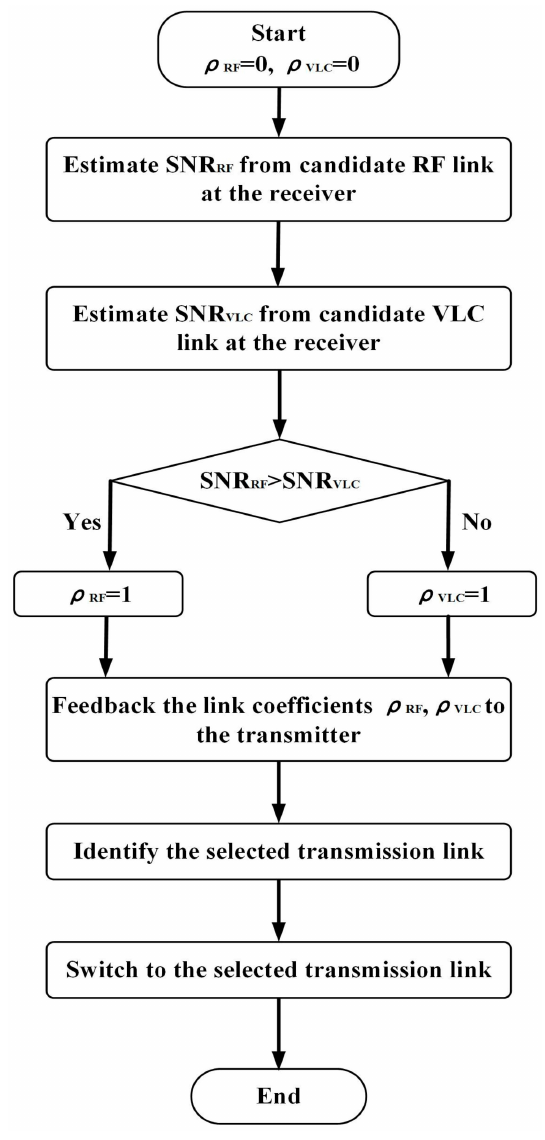
Figure 5. Flow chart for the operation mechanism of homogeneous optical beams-based hybrid VLC/RF hard switching